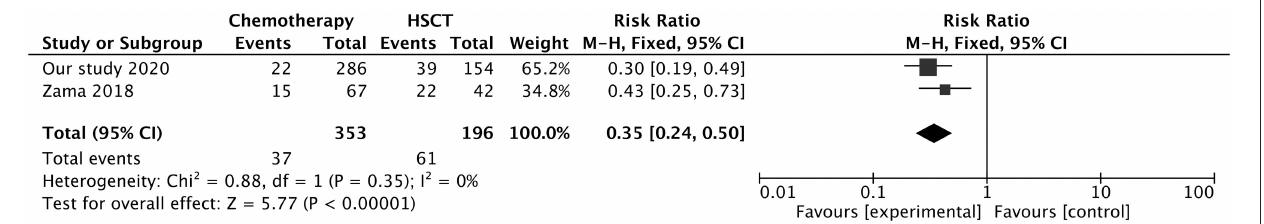
FIGURE 3 | Forest plot for the comparison of mortality between Chemotherapy and